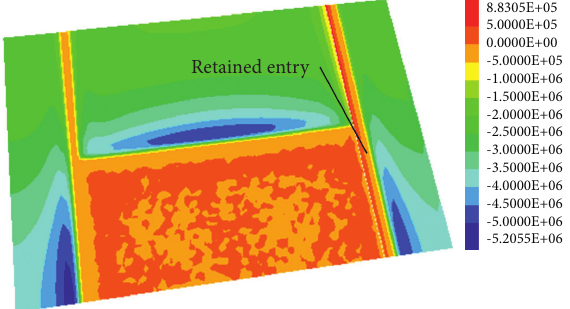
Figure 17: The vertical stress distribution simulation results of the B-B section (unit: